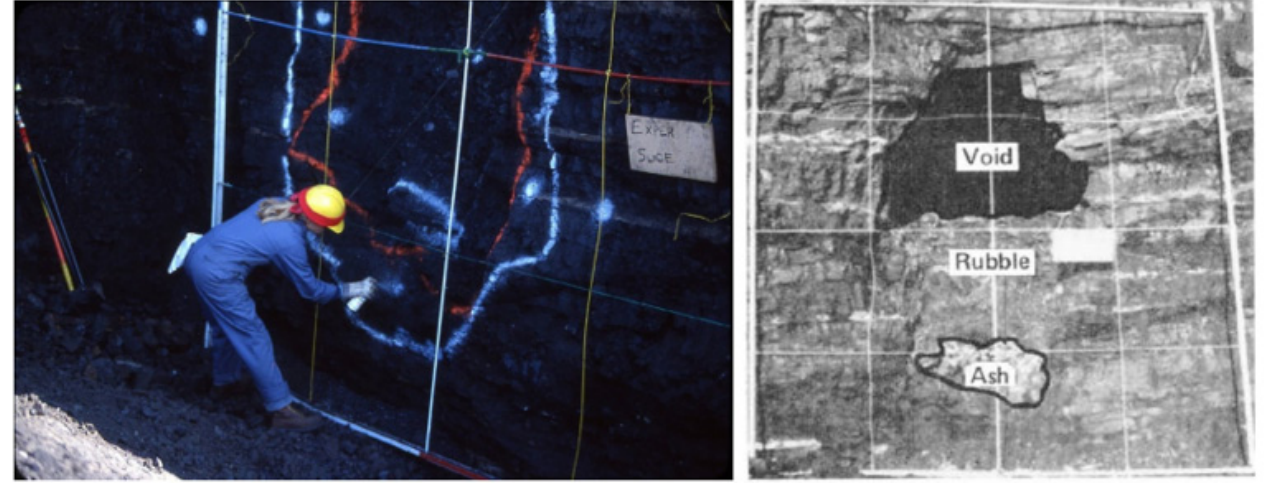
Figure 3. The cavity for large UCG trial at Centralia mine (from [21,22]).